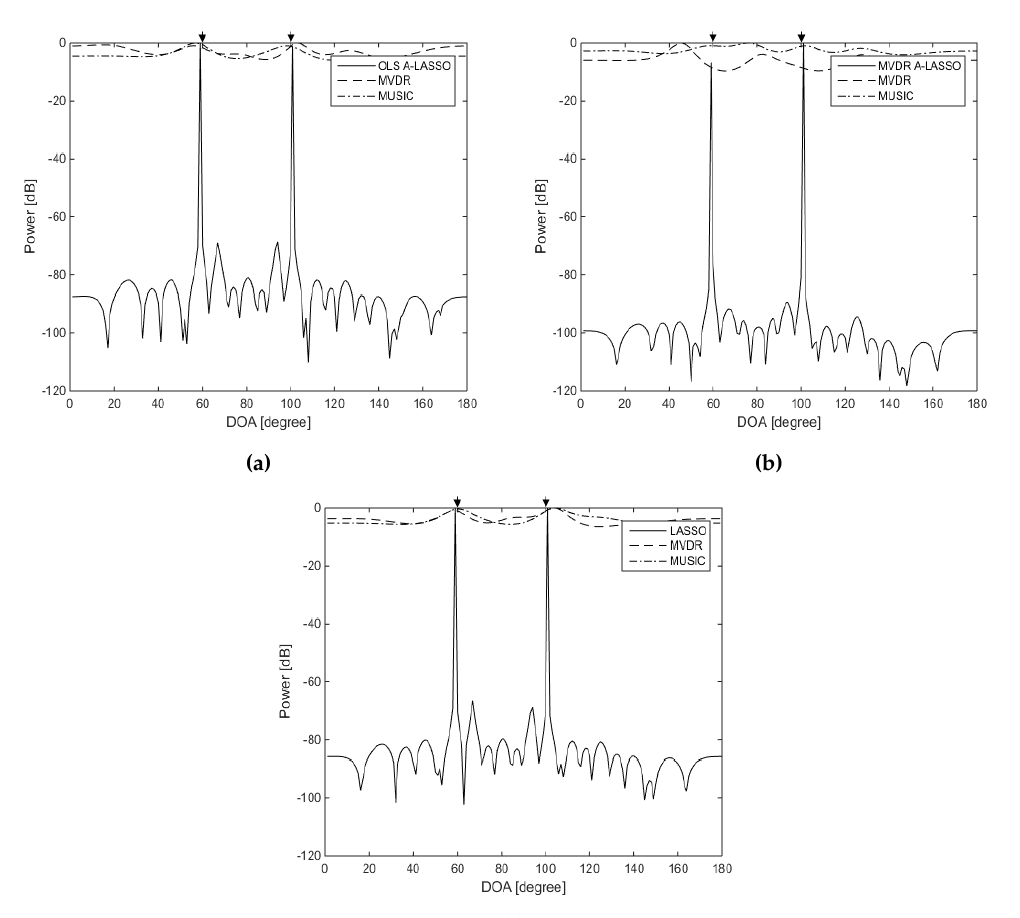
Figure 10. DOA estimation for two correlated source signals using LASSO algorithms, for two source signals at DOAs 60 ◦ and 100 ◦ , 10 snapshots, SNR = 15 dB and one iteration of the MVDR A-LASSO and OLS A-LASSO algorithms. ( a ) OLS A-LASSO after the first iteration; ( b ) MVDR A-LASSO after the first iteration; and ( c ) the classical LASSO